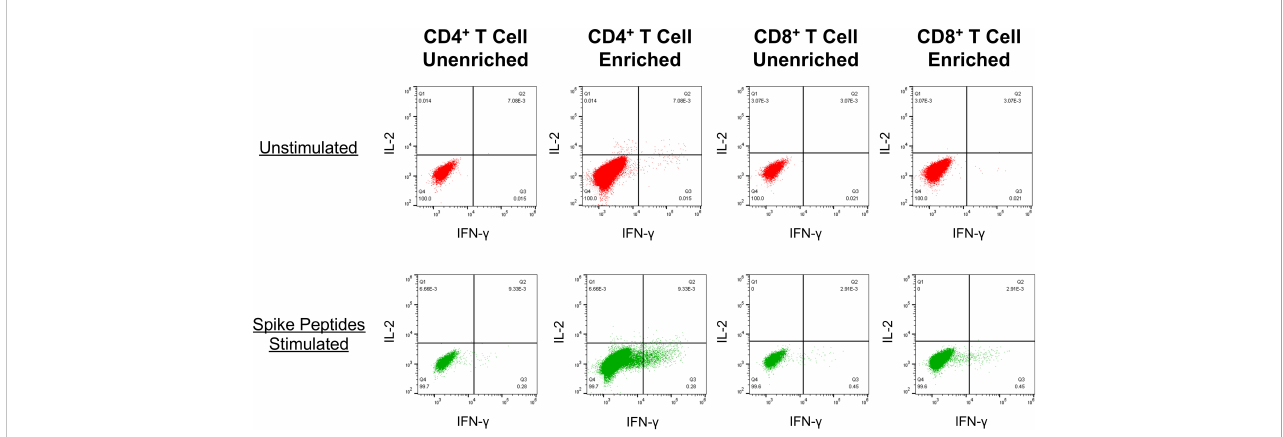
FIGURE 4 PBMC cultured with the mRNA-1273 vaccine in vitro reveal enrichment of spike-speci fi c memory CD4+ and CD8+ T cell responses . An example is shown for detection of spike-speci fi c T cells (as described in Figure 2.) in PBMCs from a SARS-CoV-2-naïve person who had completed vaccination with mRNA-1273 128 days prior. Top row: The PBMC were directly tested for T cell reactivity against spike. Bottom row: Prior to testing, the PBMC were cultured with the addition of mRNA-1273 vaccine for 14 days before testing for spike-speci fi c T